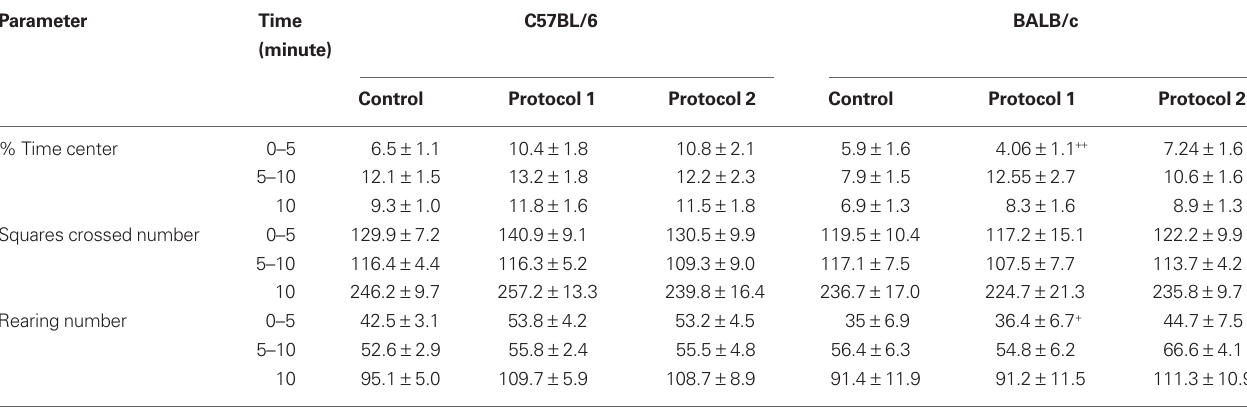
Table 1 | effect of MS on behavior in the open-field test by 5-min blocks. Parameter Time C57BL/6 BALB/c